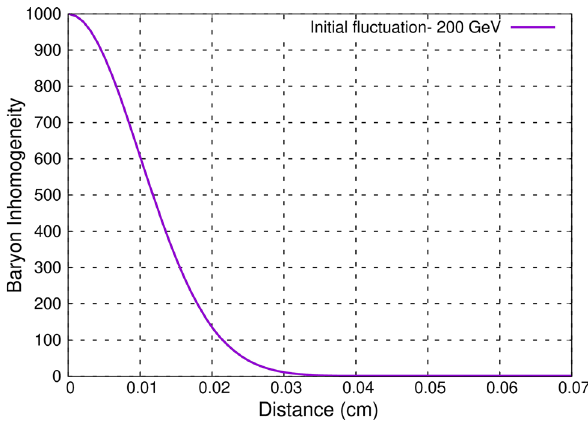
Fig. 2 The decay of the fluctuation is shown in logscale between 200 and 17 GeV as the quarks moves through a sea of electrons. The fluc- tuation is smaller at higher temperatures and spreads out further as temperature decreases